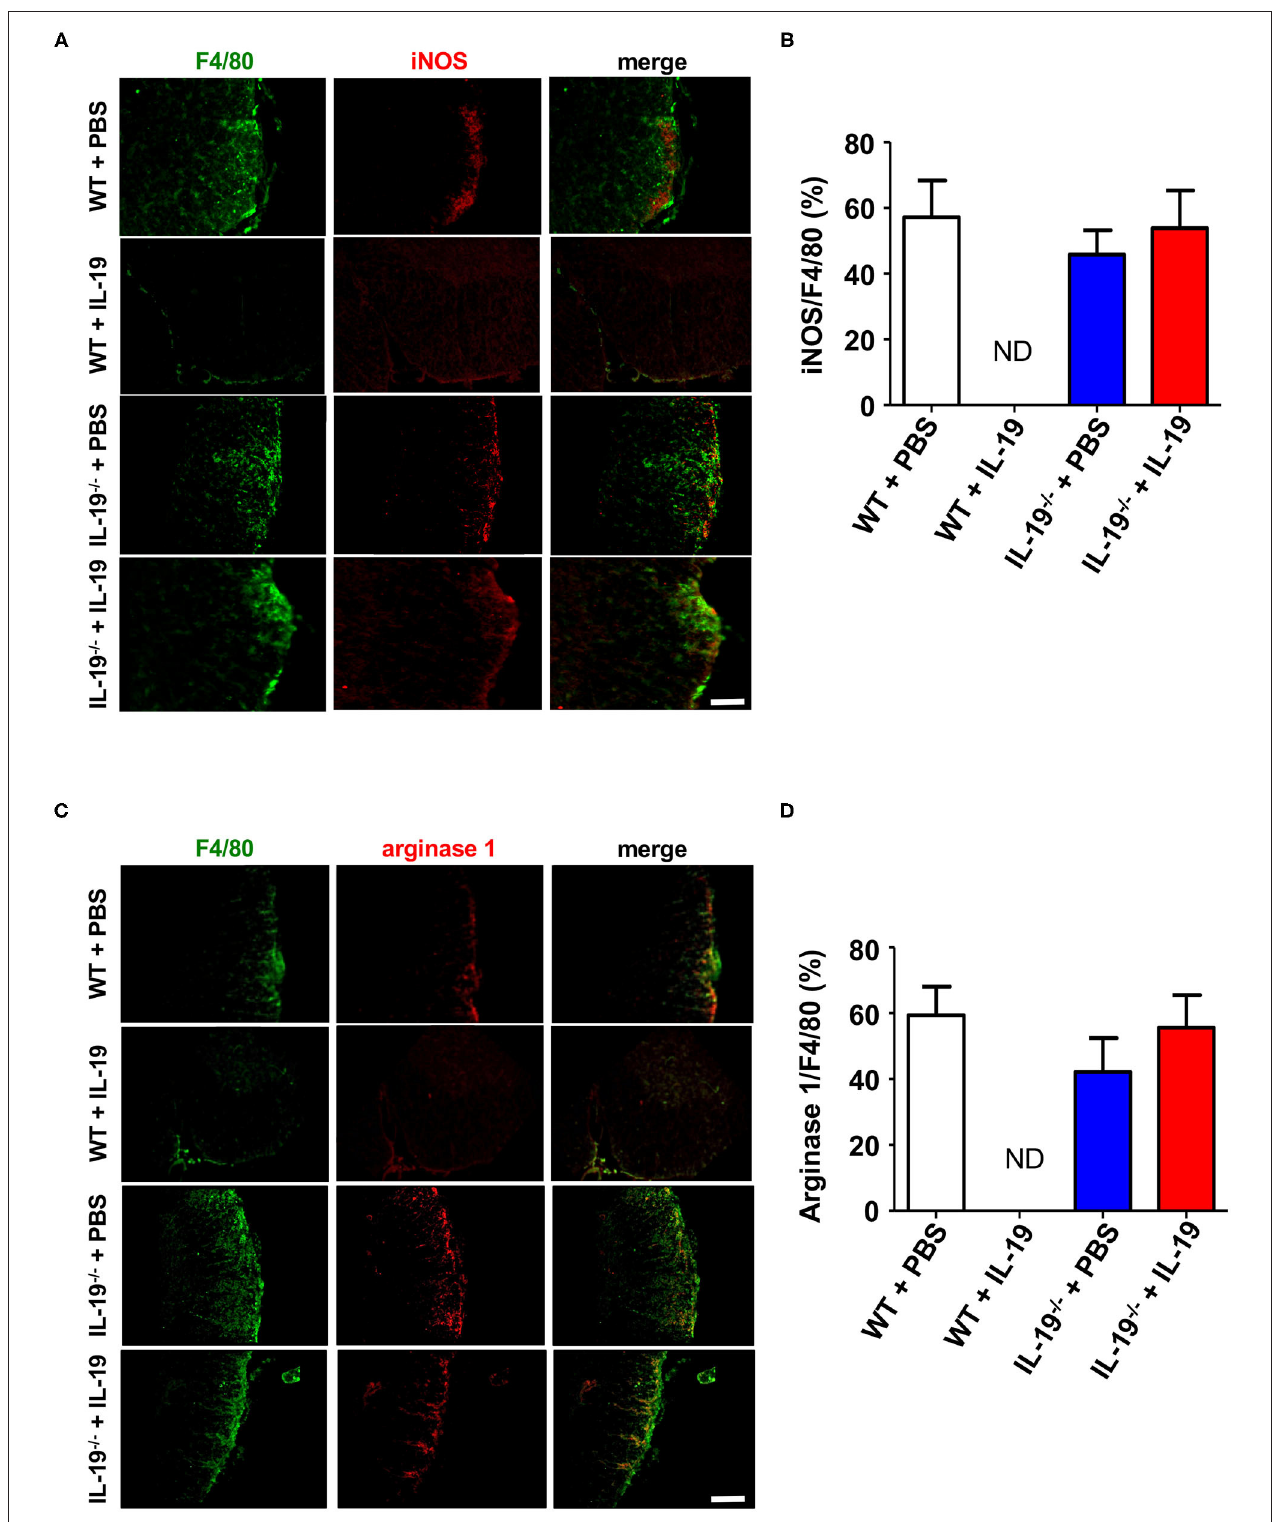
FIGURE 7 | Treatment with recombinant IL-19 did not alter macrophage phenotype. (A) Representative immunohistological images of L5 lumbar spinal cord sections from EAE mice. Pro-inflammatory M1 macrophage (iNOS) were examined. (B) Quantitative data of A. IL-19 treatment did not alter the number of iNOS + F4/80 +